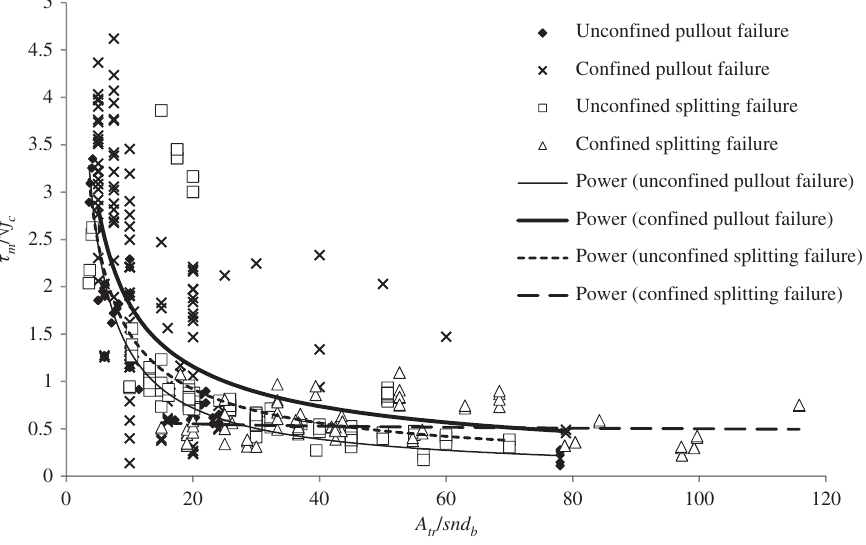
Figure 9: Normalised average bond strength against normalised transverse reinforcement